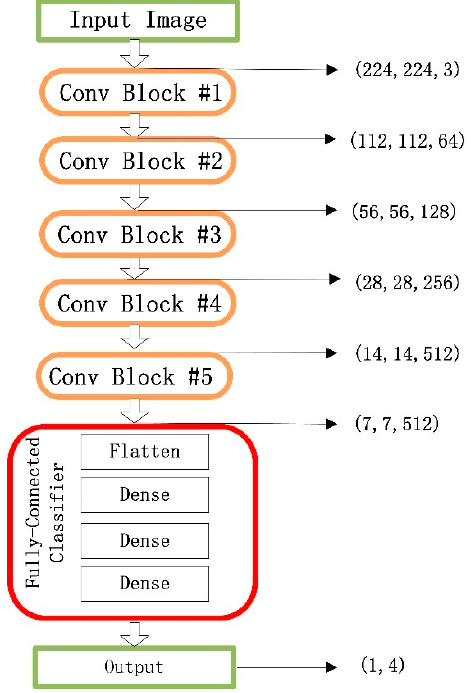
Figure 2. A schematic of the VGG16 architecture.